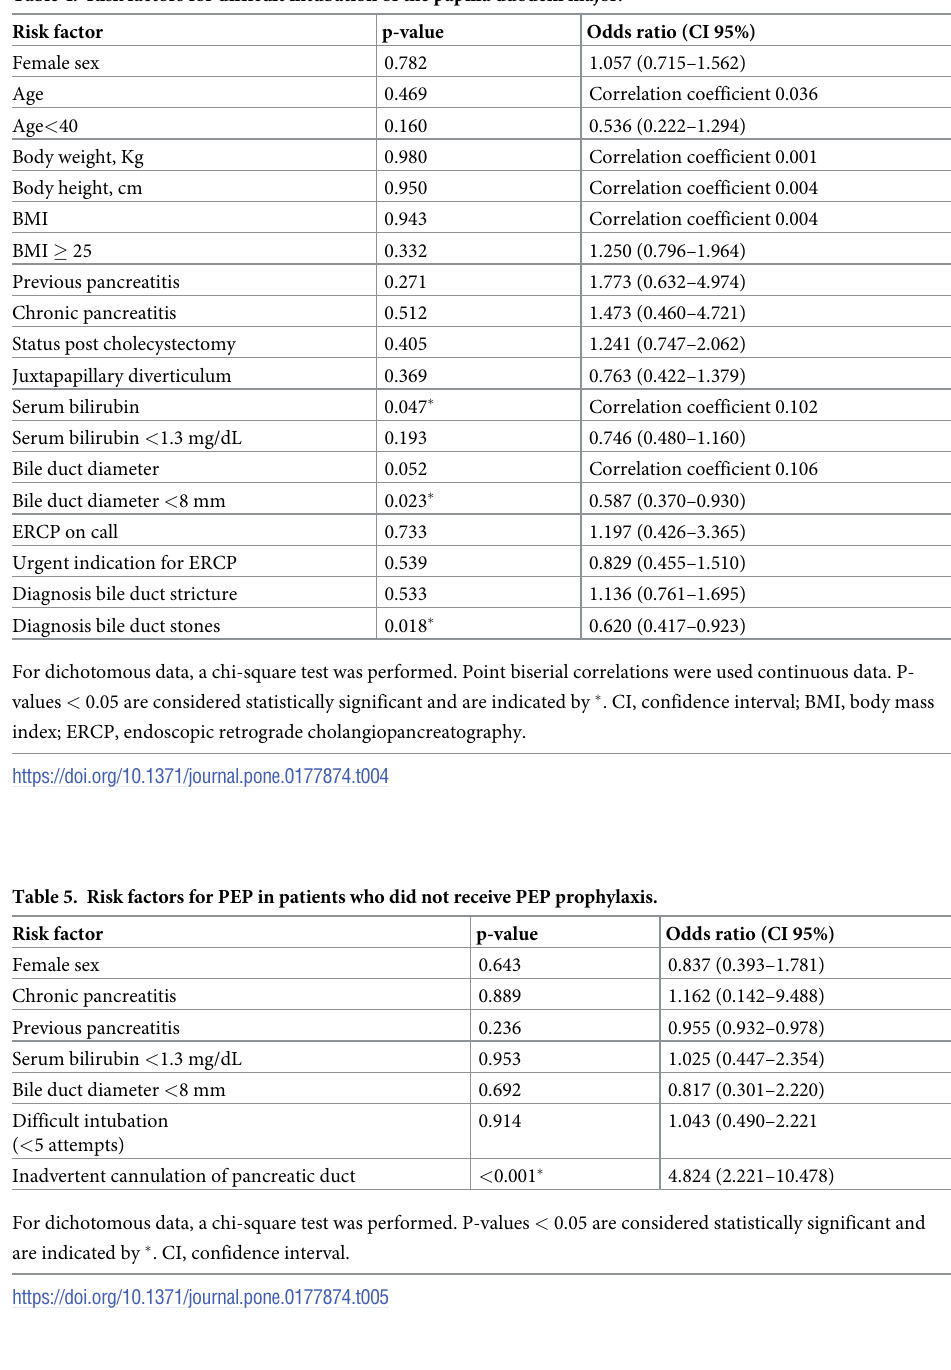
Table 4. Risk factors for difficult intubation of the papilla duodeni major.